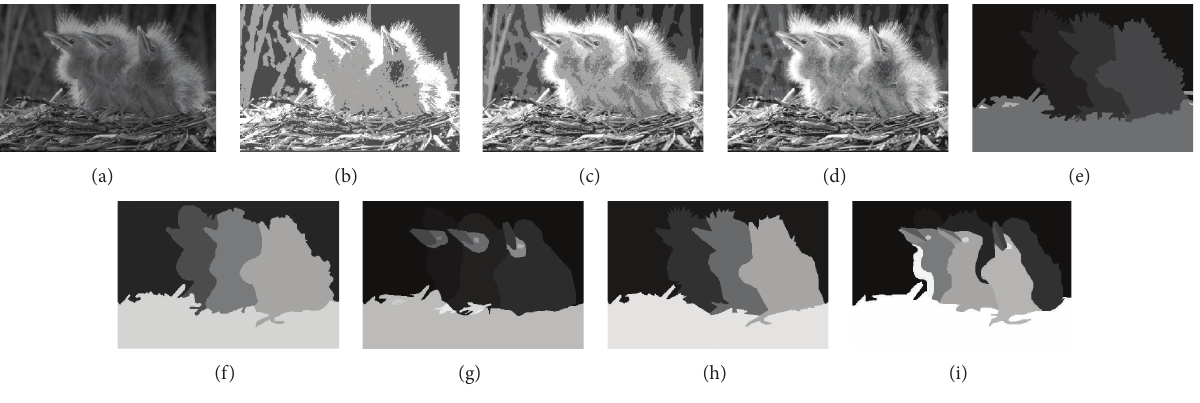
Figure 11: (a) Original image 163085, (b) M − 1 = 2 PRI = 0.61394 , (c) M − 1 = 5 PRI = 0.67958 , (d) M − 1 = 9 PRI = 0.70398 , (e)–(i) the ground-truth hand segmentations offered by Berkeley Segmentation Dataset. Table 7: Objective values and thresholds by the Otsu method and their PRI.